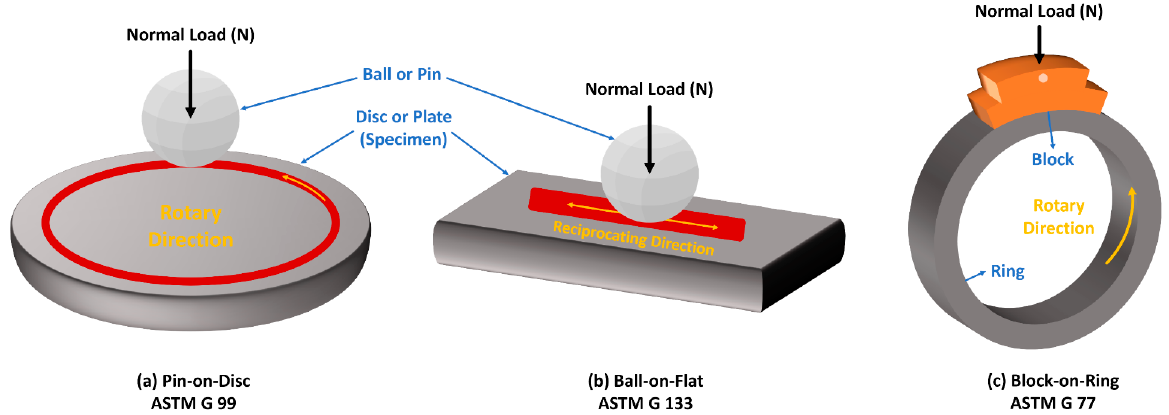
Figure 12. Schematic representing the three main configurations for wear test along with the corre- sponding ASTM standard.